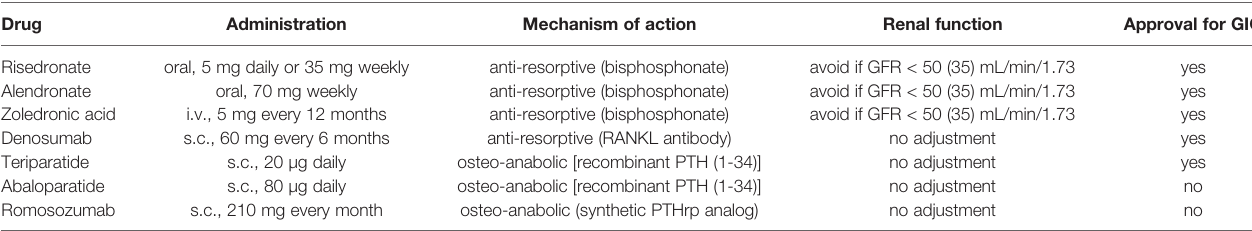
TABLE 1 | Current and future pharmacological GIO